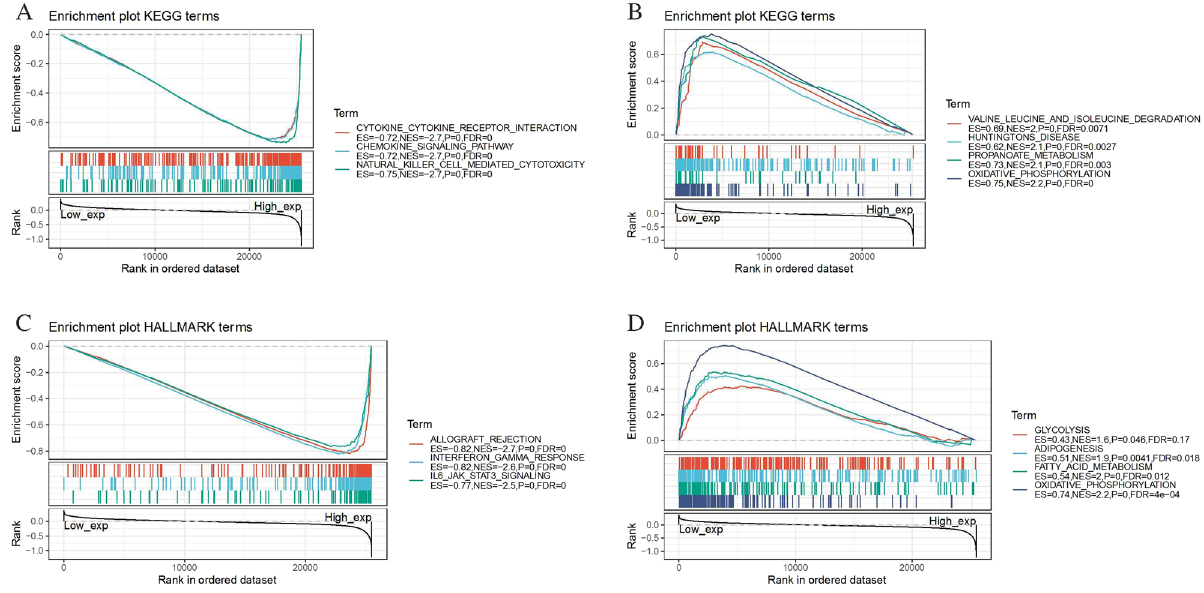
Figure 9. Functional Enrichment of KEGG and HALLMARK terms on TIGIT through GSEA. The top three negative and positive enriched KEGG terms were displayed in ( A ) and ( B ) respectively. The top three negative and positive enriched HALLMARK terms were displayed in ( C ) and ( D )